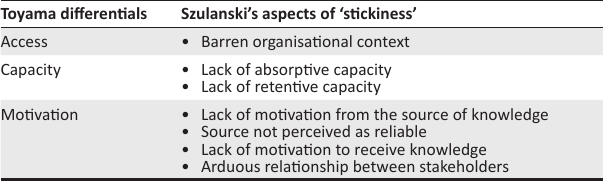
TABLE 3: A comparison of information and communication technology for development differentials and aspects of stickiness.